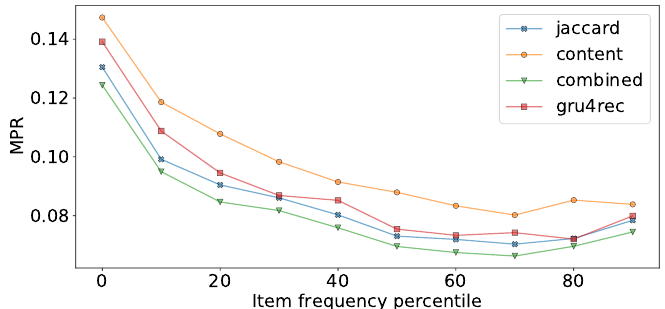
Figure 9. Performance of the different Gru4Rec based models in case of different item